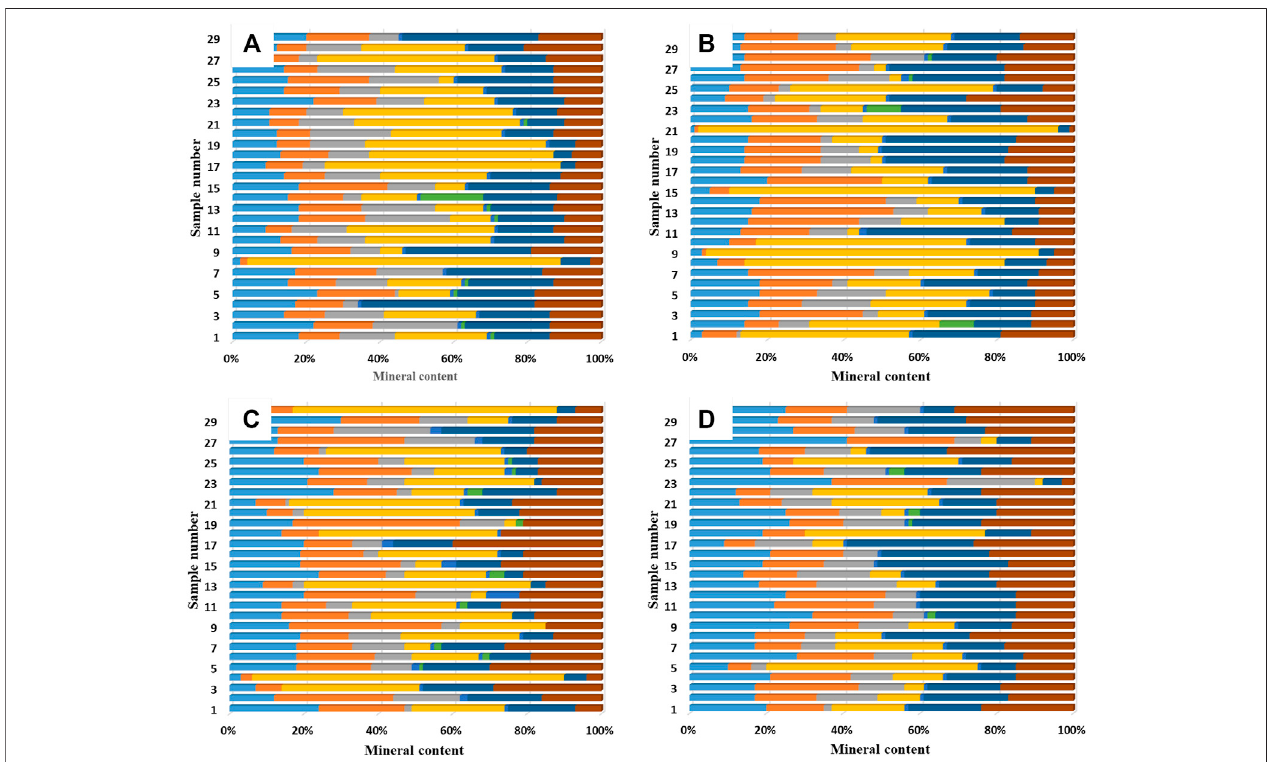
FIGURE 5 | The whole-rock mineral component of shale samples from Ek 2 . (A) Ek 21 ; (B) Ek 22 ; (C) Ek 23 ; (D) Ek 24 .